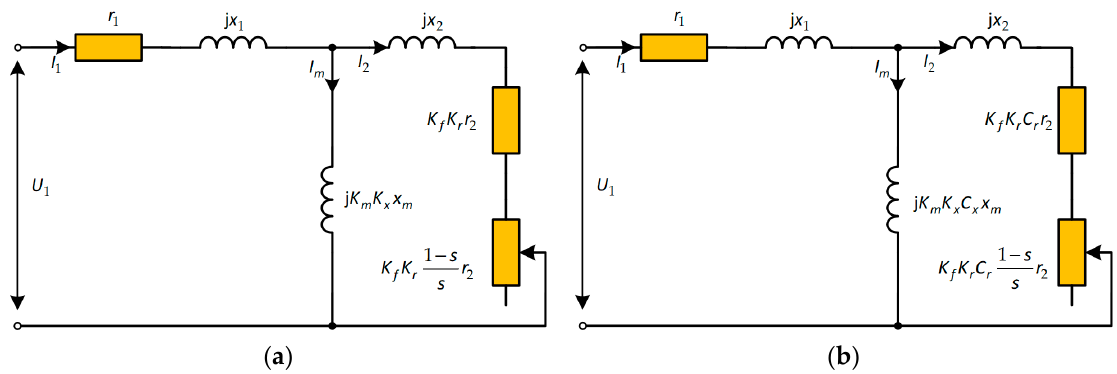
Figure 6. Novel equivalent circuits of DLIM: ( a ) with skin effect, secondary leakage reactance, and longitudinal end effect considered (EC-LS); ( b ) with longitudinal end effect, transverse end effect, and skin effect and secondary leakage reactance considered (EC-LTS).